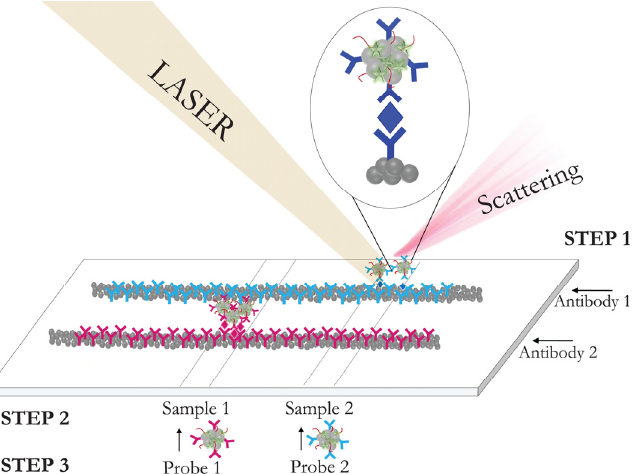
Figure 6. SERS microfluidic chip with AgNPs in microchannels, functionalized with capture antibodies. After injection of analyzed samples and SERS nanotags, the sandwich complexes are formed in microchannels, and SERS signals indicate presence of corresponding analytes.